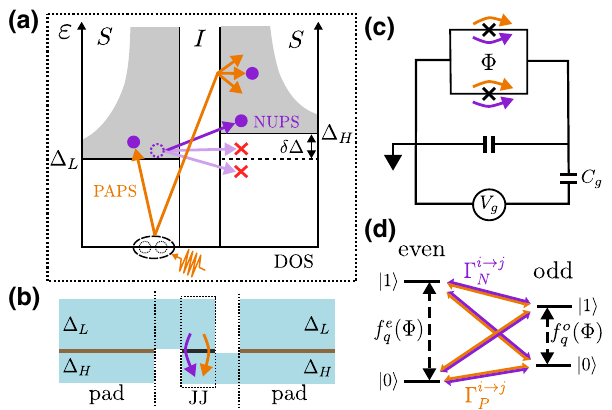
FIG. 1. (a) The superconducting density of states of the JJ in the excitation picture, with a difference in the superconducting gaps δ(cid:2) of the aluminum films. Two parity-switching mecha- nisms are illustrated. The first conserves the QP number while the second generates two QPs. Number-conserving parity switch- ing (NUPS, purple): a preexisting QP may tunnel while exciting, relaxing, or without exchanging energy with the qubit. Some cases of QP-qubit interactions may be suppressed by lack of available final states (red cross). Photon-assisted parity switch- ing (PAPS, orange): a photon with energy greater than (cid:2) L + (cid:2) H may be absorbed at the JJ, breaking a Cooper pair to generate two QPs, with one tunneling across the JJ. (b) A cross-section sketch of the device, formed by one thinner higher-gap film and one thicker lower-gap film. The arrows represent NUPS (pur- ple) and PAPS (orange) tunneling across the JJ. Like the JJ, the pads of the device consist of a bilayer of both films but have an approximately 10 6 times larger contact area. This large con- tact area ensures that QPs in the pads may rapidly redistribute between the two films as discussed in Sec. III. (c) The circuit diagram of a flux-tunable offset-charge-sensitive transmon. Fluc- tuations in the charge environment may induce offset charge n g = C g V g / 2 e . Both NUPS and PAPS across either JJ result in a switch of the parity, which appears as a sudden jump in n g by 1 / 2. (d) The level diagram showing the qubit ground ( | 0 (cid:5) ) and excited ( | 1 (cid:5) ) states separated into even- and odd-parity man- ifolds. Both NUPS and PAPS cause a switch between even and odd parity and may relax or excite the qubit. For E J / E C (cid:2) 30, (cid:2) (cid:2) (cid:4) (cid:3) (cid:2) (cid:2) (cid:3) 500 n g = 0 f qe − f qo